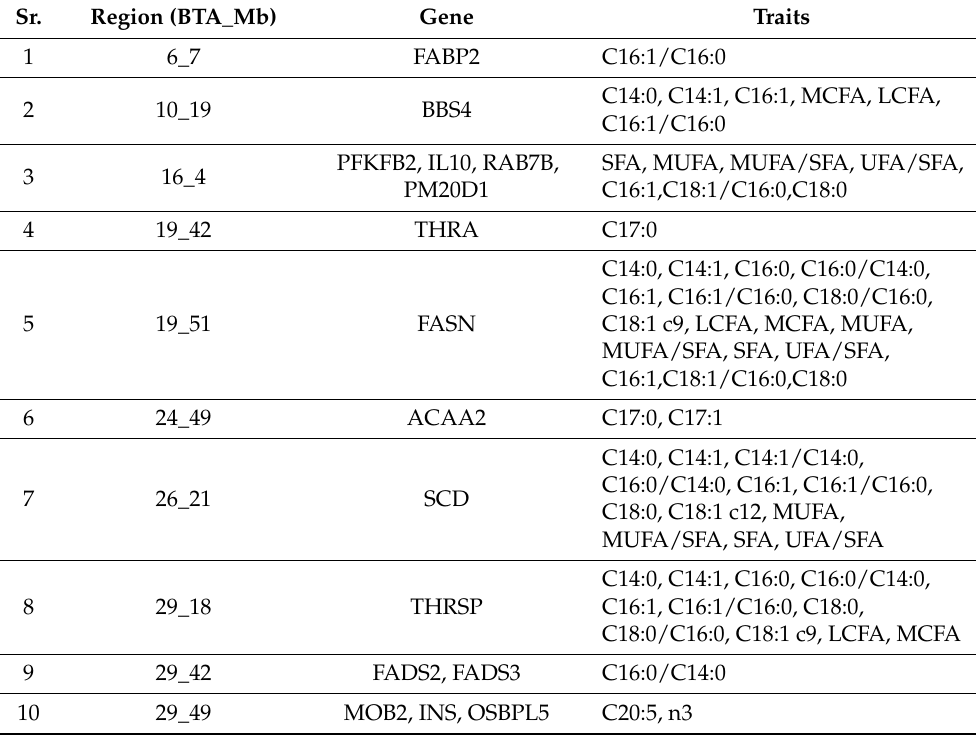
Table 4. 1Mb chromosome windows having candidate gene associated with fatty acid traits.